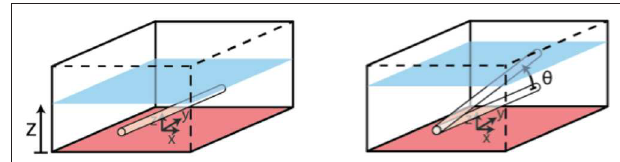
FIGURE 6 | Set up for testing of phantom submersion depth and incline angle. Controlled variables are z and ϑ .